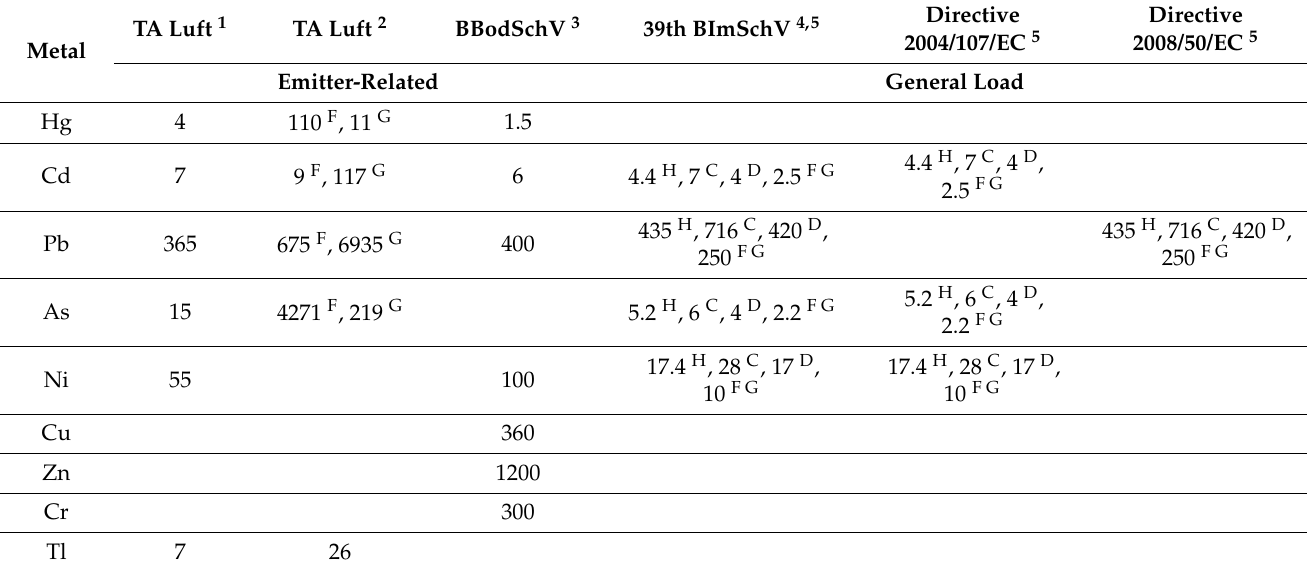
Table 1. Assessment values for heavy metal fluxes (g ha − 1 a − 1 ) for the protection of ecosystems and human